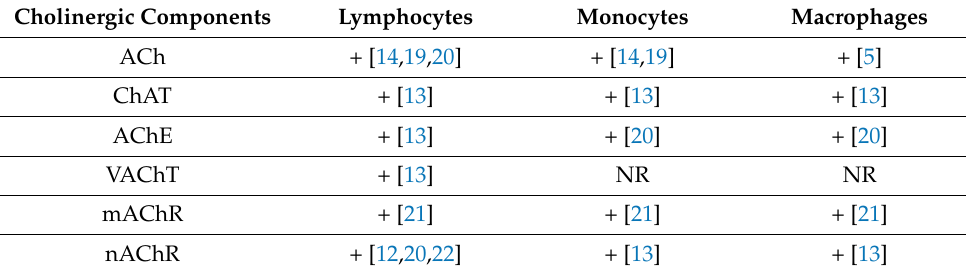
Table 1. Expression of the cholinergic system components in immune